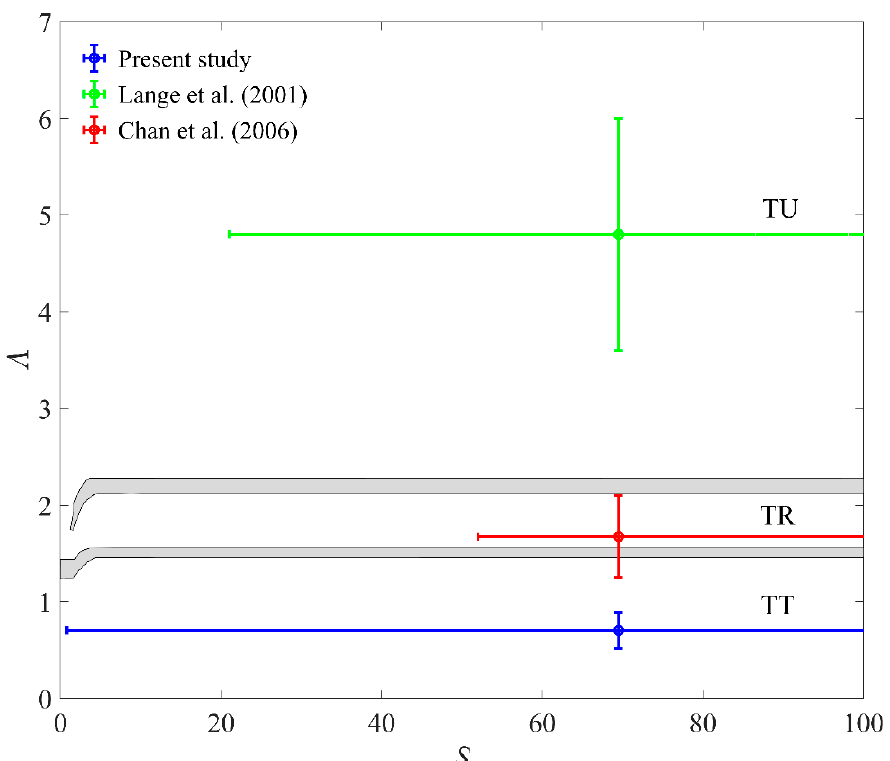
Figure 4. Phase diagram of the vesicle dynamical state with data from Lange et al. [27], Chan et al. [28] and Deschamps et al. [54]. TU stands for tumbling state, TR for trembling state, and TT for tank-treading state. Grey bands are the transition regions identified experimentally by Deschamps et al. [54]. The ranges of values of S and Λ for this study and other relevant studies with E. coli are reported with bars (note that the diagram is cut-off at S = 100 for graphical reasons). Table 1. Values of morphological and mechanical parameters of cell envelopes for E. coli (unless differently specified) from the literature. According to the literature [55] E. coli cells can be represented by end-capped rods/cylinders.